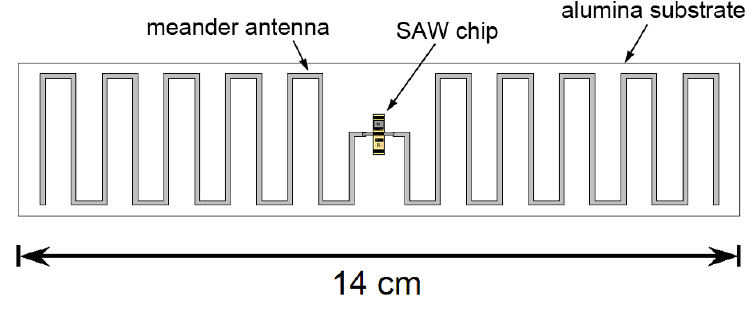
Figure 22. Conceptual design of SAW gas